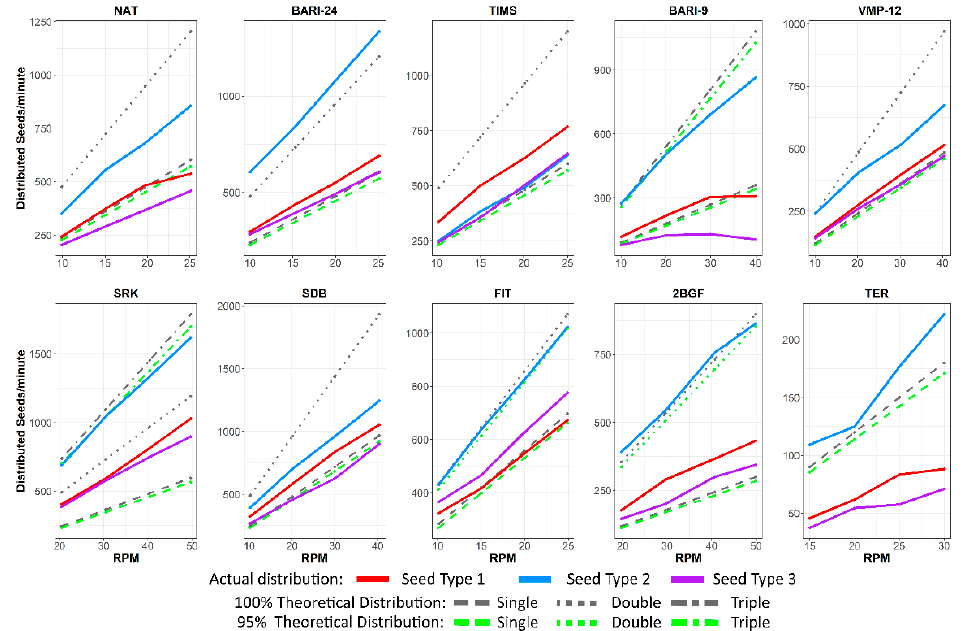
Figure 4. Effect of plate velocity (revolutions per min—RPM) for the different seed meters on actual seed distribution for the three seed types (Seed type 1—medium round, Seed type 2—small drop-shaped and Seed type 3—flat and large), compared with 100% and 95% of the theoretical distribution at three filling rates. Note more detail of the different mechanical maize seed meters given in Figure 2.